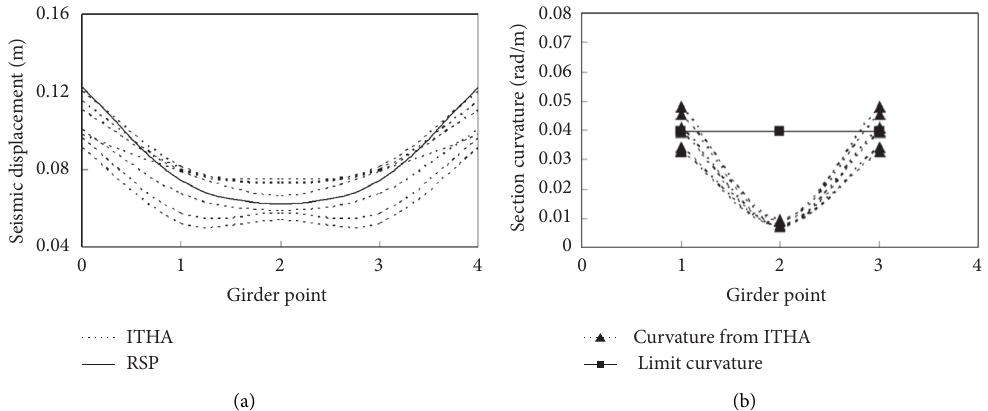
Figure 13: Check of design result: (a) seismic displacement calculated by RSP and ITHA and (b) curvature of the pier base